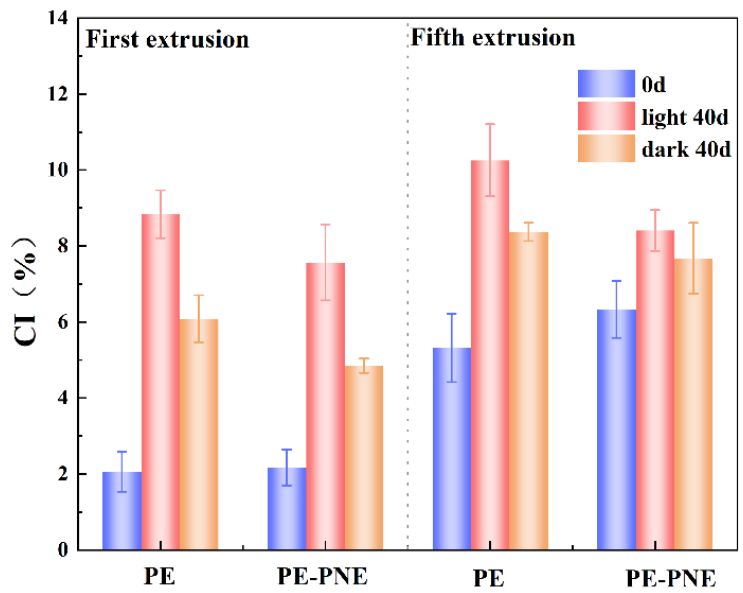
Figure 3. Carbonyl index (CI) of PE-PNE vs. extrusion and storage. Table 1. The increments of carbonyl index values ( ∆ CI) of PE and PE-PNE samples after long-term storage (40 days) under daylight or in the dark.